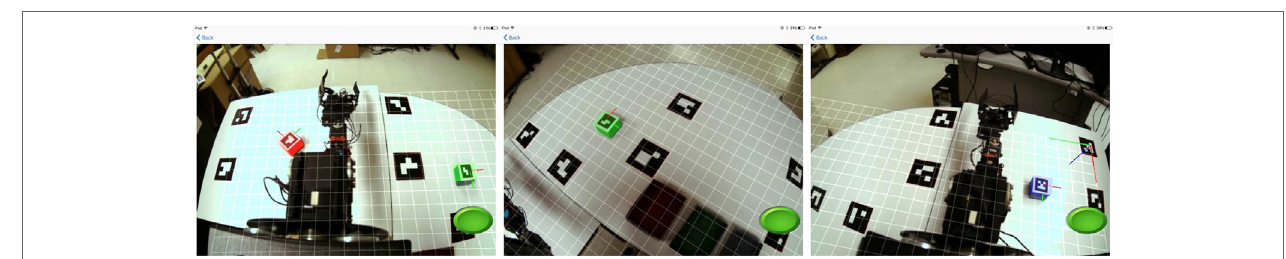
FigUre 5 | egocentric views of the workspace as captured from the robot-mounted camera